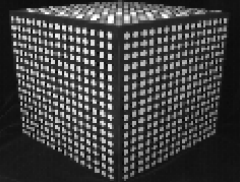
Figure 1. Non planar pattern used to calibrate a camera with Heikkila’s method ( image credits [4])